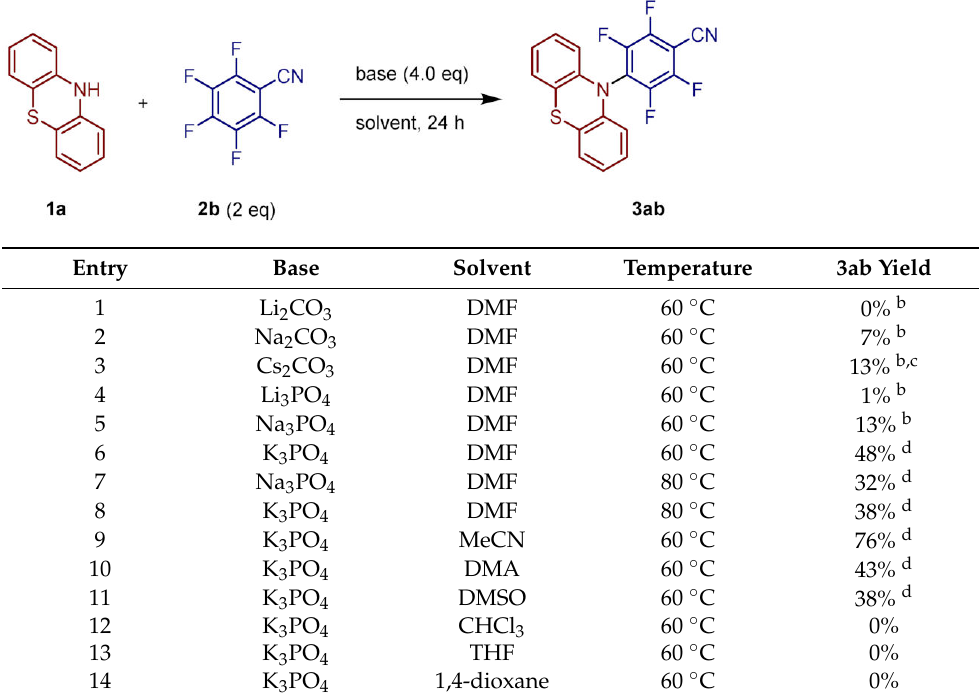
Table 1. Optimization of reaction conditions using pentafluorobenzonitrile a